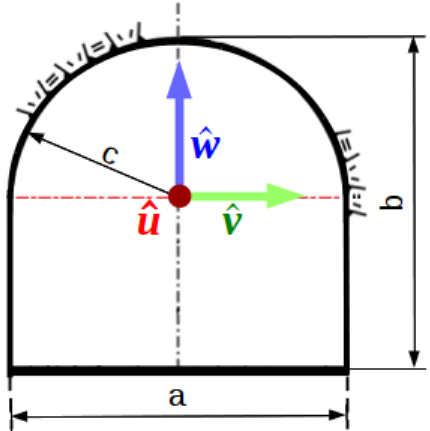
Figure 2. An example of tunnel cross-section with base with length a , the tunnel height is b and its arc shaped ceiling has radius c . Vectors ˆ u , ˆ v and ˆ w are the normalized basis vectors of the tunnel reference frame, where ˆ u is orthogonal to the cross-section of the entrance of the